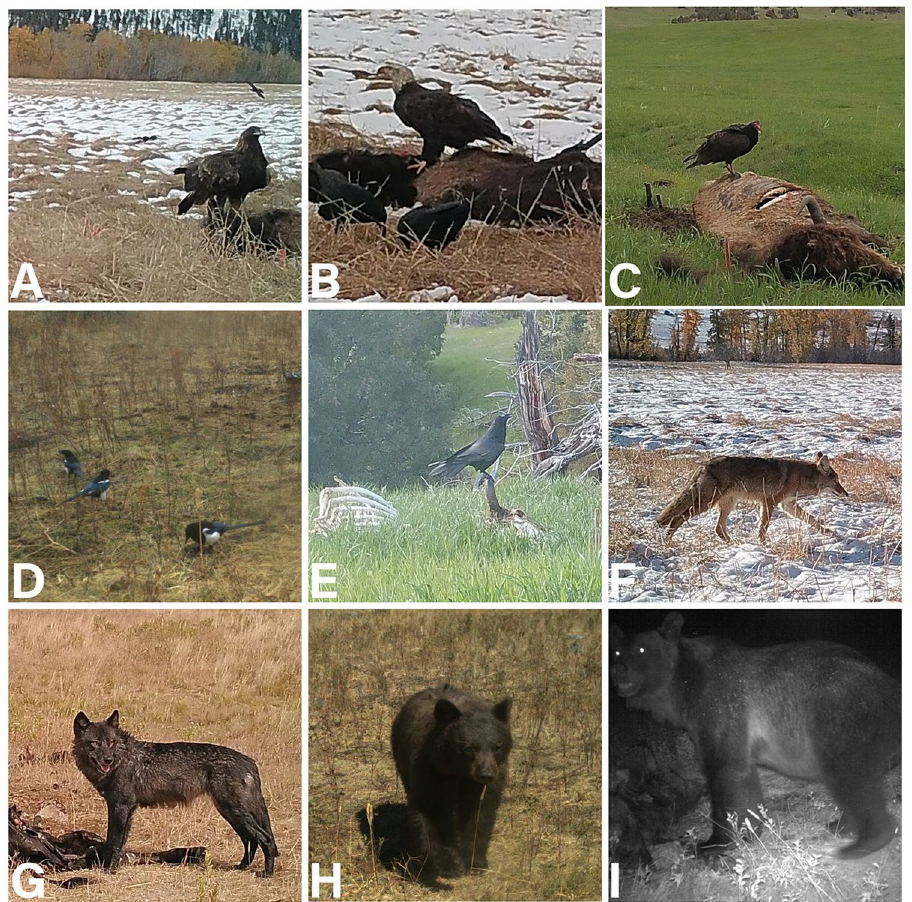
Figure 1. Images of scavenger species captured by motion-sensitive cameras deployed during a camera trap study of carcass use in southwestern Montana: golden eagles ( A ), bald eagles ( B ), turkey vultures ( C ), black- billed magpies ( D ), Corvus spp. ( E ), coyotes ( F ), wolves ( G ), black bears ( H ), brown bears ( I ). All images were captured by motion